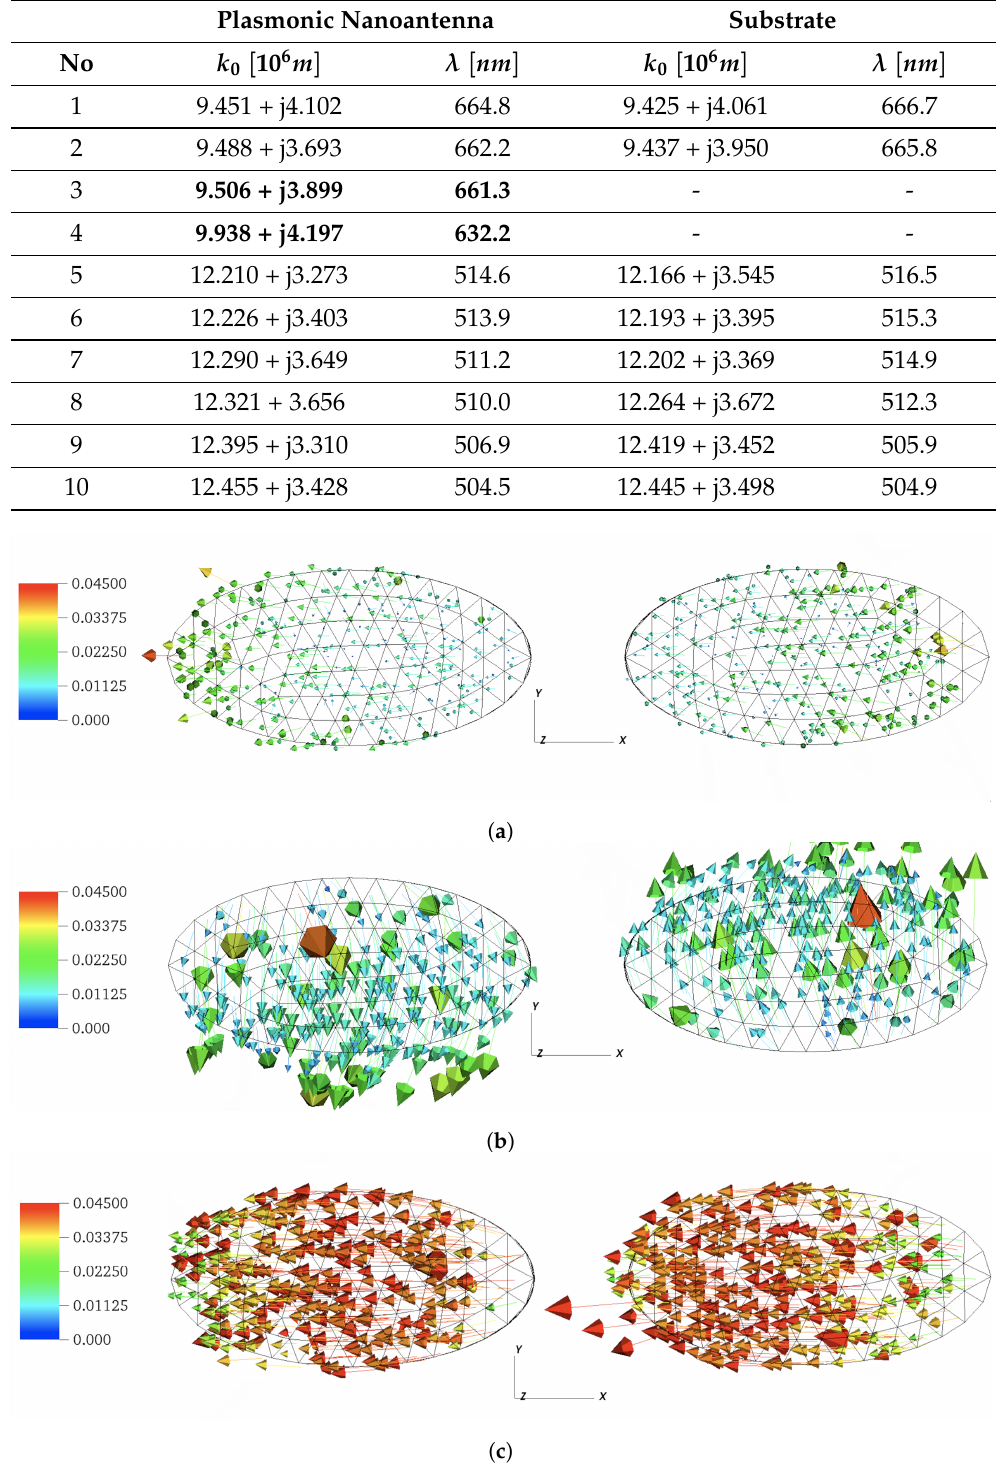
Figure 14. Electric current density on the gold particles for eigenvalues ( a ) #1 (substrate mode), ( b ) #3 (antenna mode), and ( c ) #4 (antenna